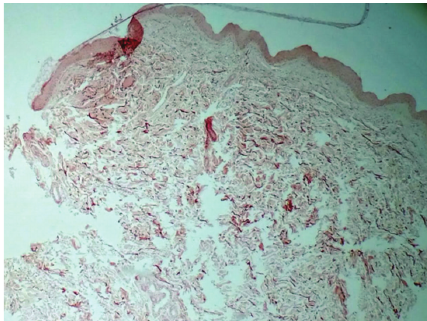
Figure 2: Histopathology view: decreased elastin content, particu- larly in mid-dermis (Acid Orcein-Giemsa ∗